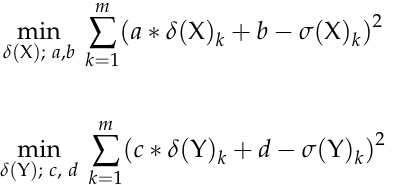
Supplementary Table S2: Chemical shift/shielding data for all carbons of aquatolide, Figure S1: Graphical presentation of data from Supplementary Table S2, Supplementary Table S3: Chemical shift/shielding data for all protons of aquatolide, Figure S2: Graphical presentation of data from Supplementary Table S3, Supplementary Table S4: Chemical shift/shielding data used to reconstruct the investigated HSQC spectrum, Figure S3: Graphical presentation of the investigated HSQC spectrum, Supplementary Table S5: Raw data used to prepare Figure 2, Supplementary Table S6: Comparison of the extrapolated results, Supplementary Table S7: Parameter values for Equation (1), Supplementary Table S8: Details of a diagonalization of the quadratic form from Equation (1), Figures S4 and S5: Approximated fragments of the isosurface; the file “aquatolide.xyz” with coordinates of the optimized structure of aquatolide; the file “diamine.xyz” with coordinates of the symmetrized structure of 3,12-di(4-aminophenyl) Ni II dimesitylnorcorrole after the optimization in chloroform; the file “complex.xyz” with coordinates of coronene and the antiaromatic model compound; the file “grid.txt” containing the 1 H CS data at 729 grid